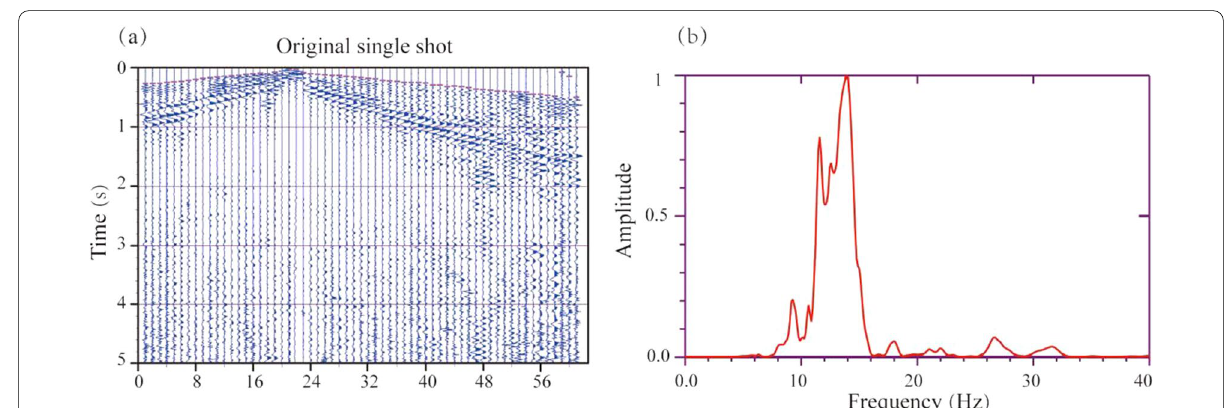
Fig. 3 Original single-shot frequency spectrum. a Original single-shot record. b Amplitude–frequency